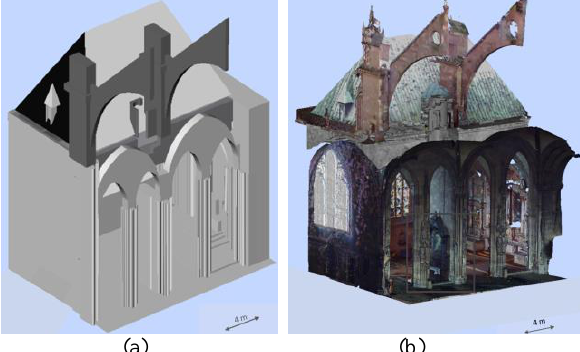
Figure 5. 3D model of the first floor and the roofs: a) based on geometric primitives adjustment; b) based on a meshing process.